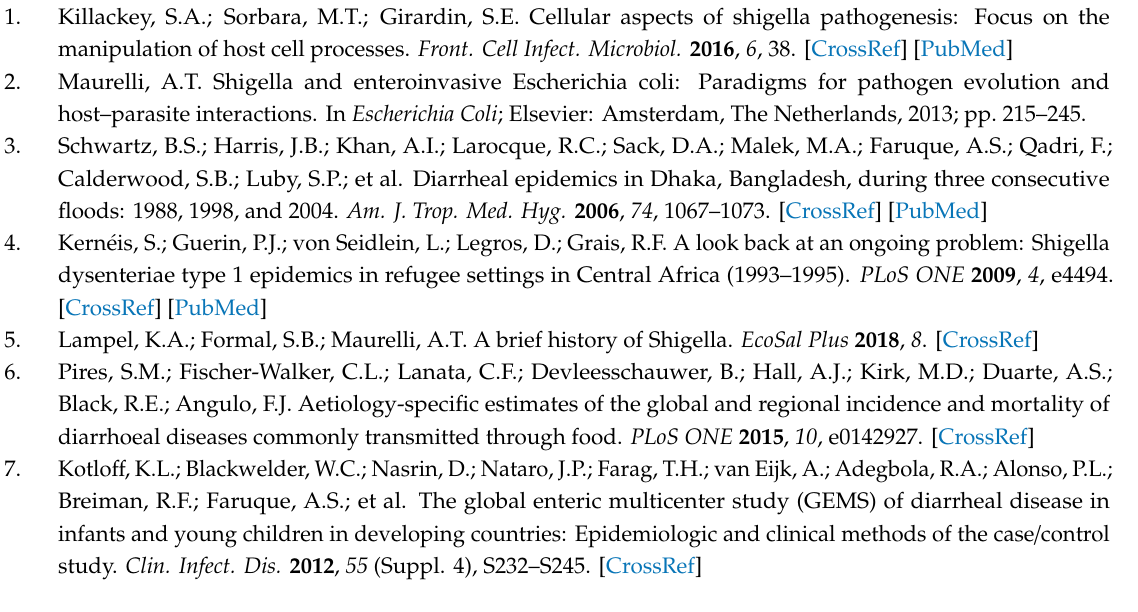
using Y394 as a reference. Only representative samples are shown in the image due to window size limitation. Figure S3. Pangenome accumulation curve of S. flexneri . The X-axis indicates the total number of genomes and Y-axis shows the number of genes - conserved vs total in S. flexneri pangenome. Figure S4. Maximum-likelihood (ML) phylogenetic tree with branch lengths drawn to scale. The ML tree was generated using the alignment of concatenated core genes with the recombination region removed. The general time-reversible model with a proportion of invariable sites (GTR + F + I) was used. The isolates from di ff erent sources were color-coded: red (Bangladesh), blue (Egypt), orange (Japan), green (UK), purple (Vietnam), and black (GenBank). The branch color represents the bootstrap support values of 1000 pseudoreplicates. The scale bar represents substitution per site. Table S1: List of bacterial strains used in the study. Table S2: List of S. flexneri core genes with reference to S. flexneri serotype 1c strain